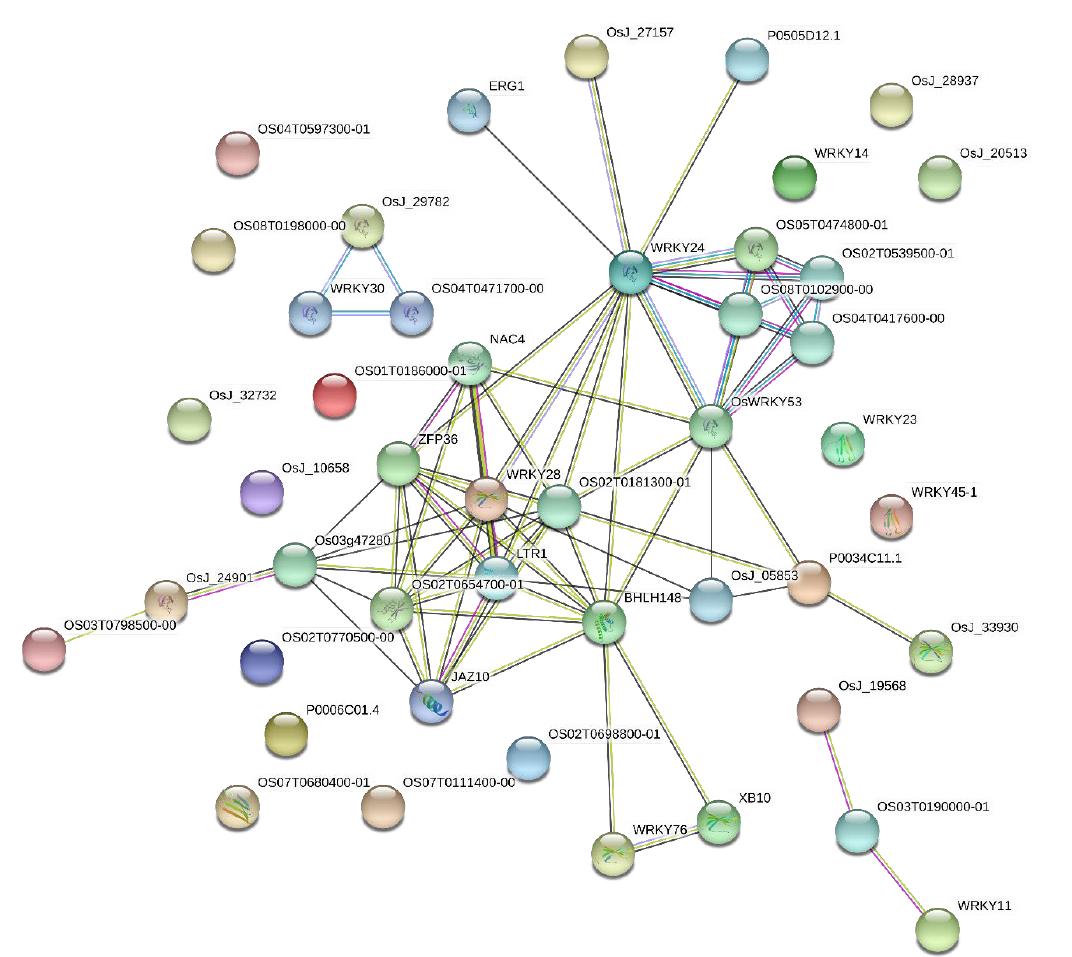
Figure 8. Molecular interaction network of 26 OsWRKY genes involved in various stress responses. The line thickness denotes the level of interaction between genes and colored lines between the genes denote various types of the interaction network. Black color, gene co-occurrence; red color, gene fusion; pink color, experimentally determined; violet color, gene homology; green color, gene neighborhood; blue color, gene co-occurrence. Gene nodes containing ribbon structures represent the presence of gene 3D structural information.